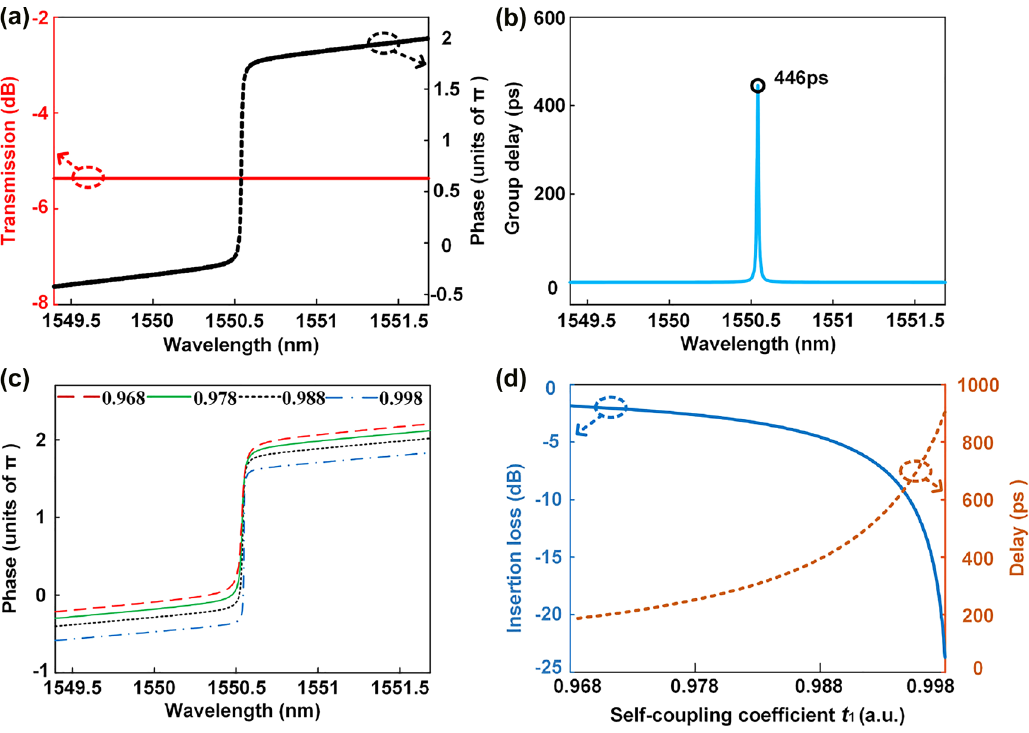
Figure 3: Simulation results of the first-order APF. (a) Amplitude (red solid curve) and phase (black short dashed curve) frequency responses when t is set as 0.968 (red dashed curve), 0.978 (green solid curve), 0.988 (black short dashed curve), and 0.998 (blue Phase responses when t 1 dashed-dotted curve). (d) Insertion loss (blue solid curve) and delay (red short dashed curve) of the first-order APF for different t